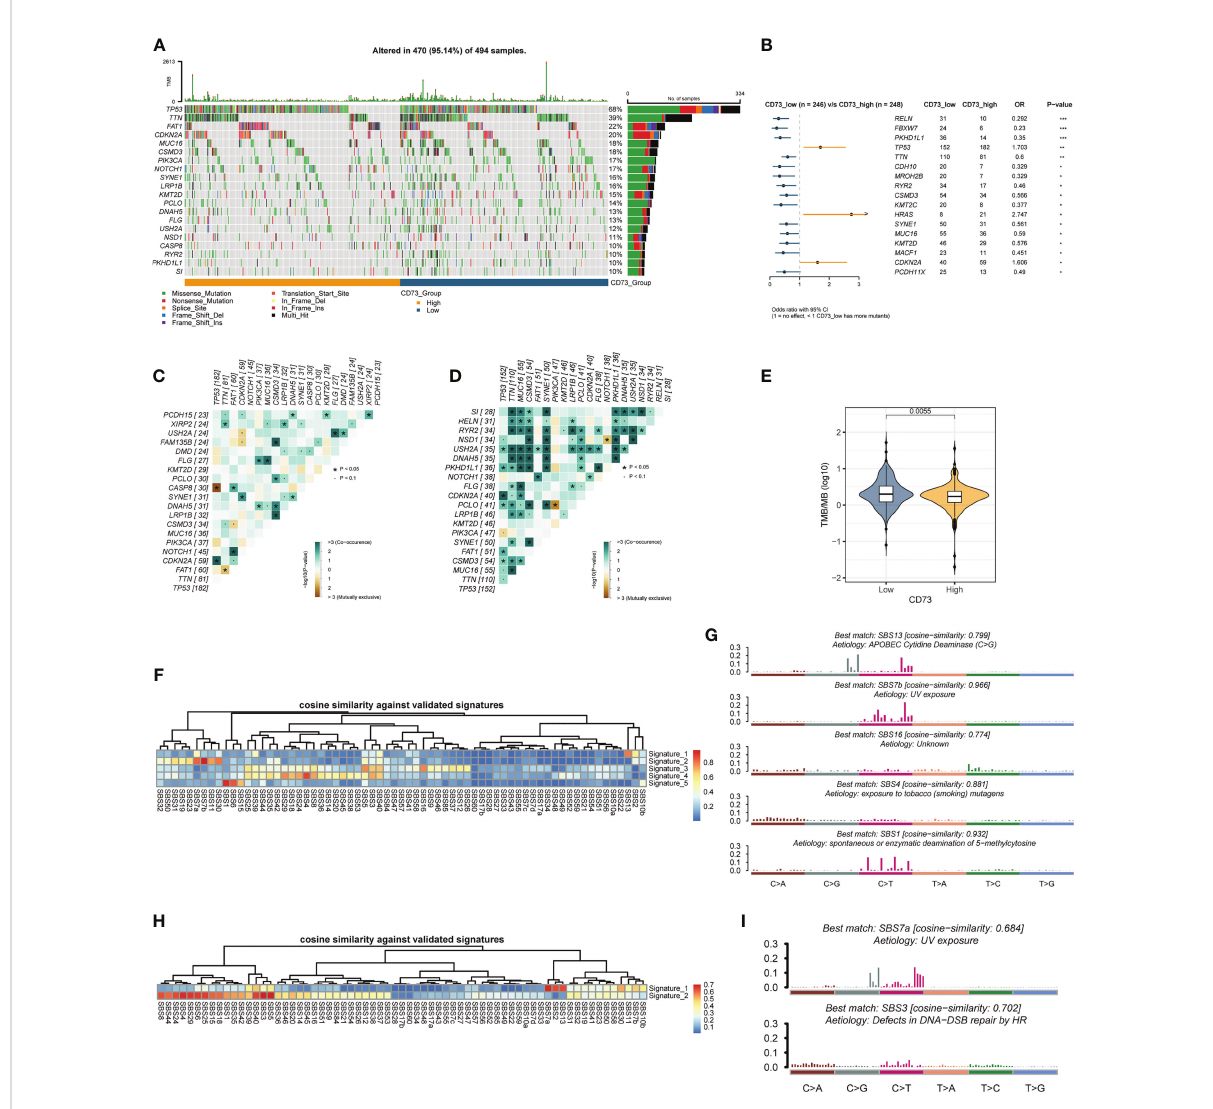
FIGURE 3 Comparison of CD73-high group and CD73-low group at the genomics level. (A) The top 20 frequently mutated genes in TCGA-HNSC tumor samples. (B) Comparison of gene mutation frequencies between CD73-high group and CD73-low group. (C) The somatic interactions plot of CD73-high group. (D) The somatic interactions plot of CD73-low group. (E) Comparison of tumor mutation burden between two groups. (F) The cosine similarity between the mutational signatures of the CD73-high group against the validated COSMIC V3 signature. (G) The identi fi ed mutational signatures of CD73-high group. (H) The cosine similarity between the mutational signatures of the CD73-low group against the validated COSMIC V3 signature. (I) The identi fi ed mutational signatures of CD73-low group. *p < 0.05; **p < 0.01; ***p <